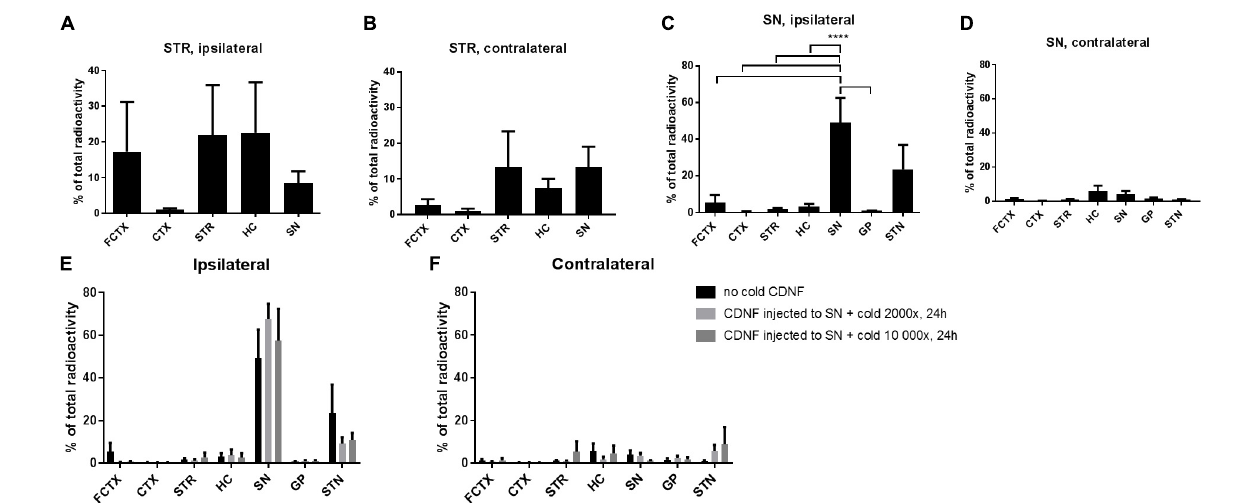
FIGURE 1 | Diffusion of 125 I CDNF when injected to the STR or SN of naive rats. (A,B) Percentage of the total radioactivity (calculated based on radioactivity of all brain areas measured) after injecting radiolabeled CDNF ( 125 I-CDNF) into the STR of naive rats and measuring 24 h later, ipsilateral regions (A) and contralateral (B) . (C,D) Percentage of the total radioactivity (calculated based on radioactivity of all brain areas measured) after injecting radiolabeled CDNF into the SN of naive rats and measuring 24 h later, ipsilateral regions (C) and contralateral (D) . (E,F) 2000 × or 10 000 × molar excess of cold (unlabeled) CDNF was given together with radiolabeled CDNF to SN of naive rats and measured 24h later. Ipsilateral regions (E) and contralateral (F) . ( n = 5–6/brain region) Bars represent mean ± SEM. ∗∗∗∗ p = < 0.0001. FCTX, frontal cortex; CTX, cortex; STR, striatum; HC, hippocampus; SN, substantia nigra; GP, globus pallidus; STN, subthalamic nucleus.